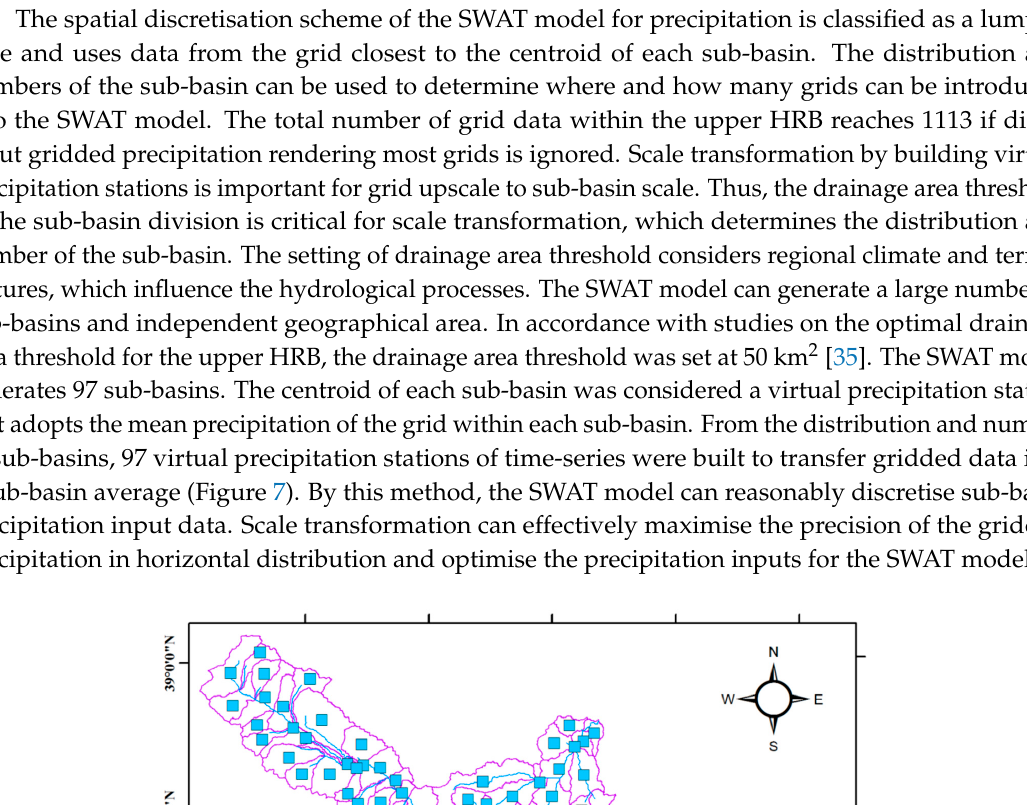
Figure 8. Distribution of the sub-basin precipitation lapse rate.